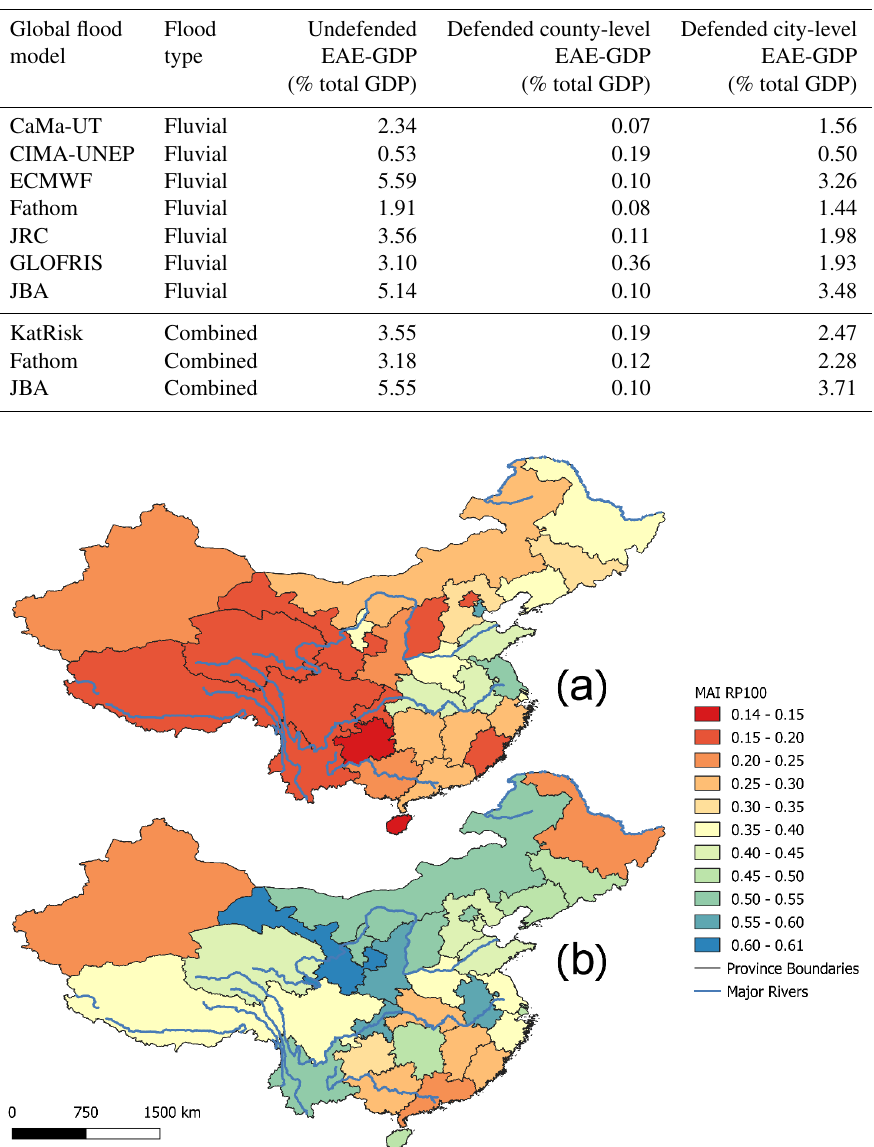
Figure 4. The spatial distribution of average MAI results on a province level for RP100 in China. (a) MAI scores for an undefended fluvial hazard map (seven GFMs). (b) MAI scores for an undefended combined hazard map (three